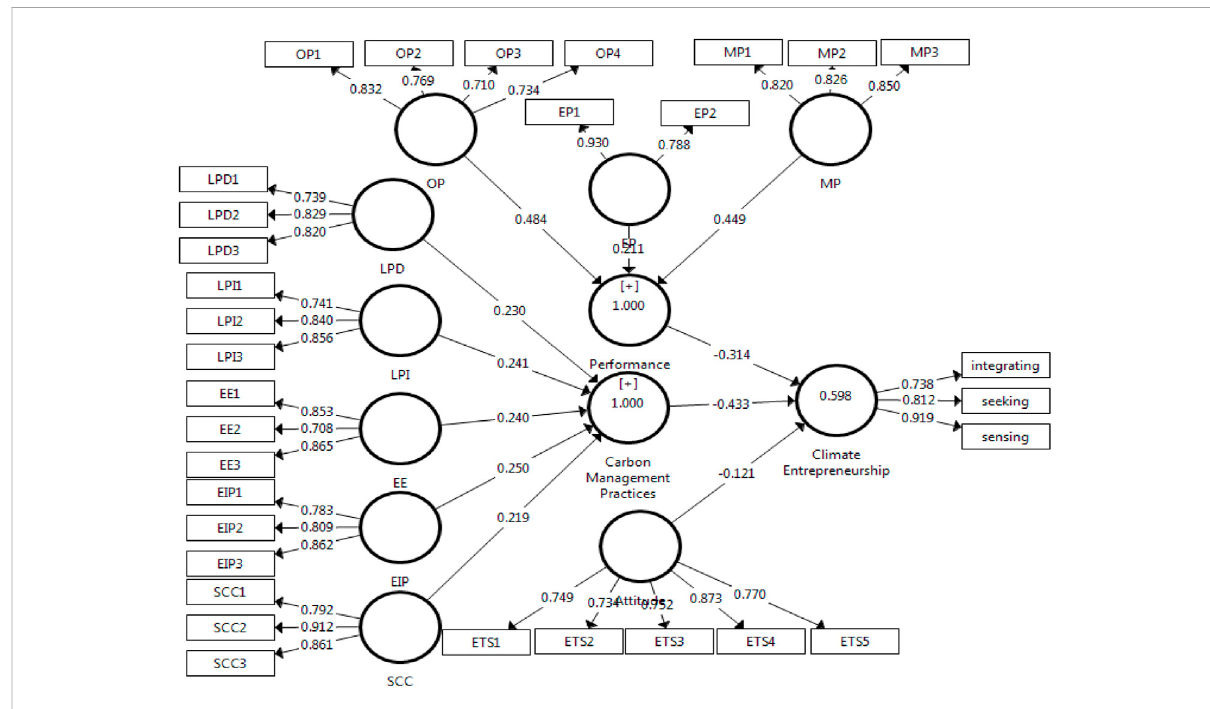
FIGURE 2 Factor loadings and structural factor in fl